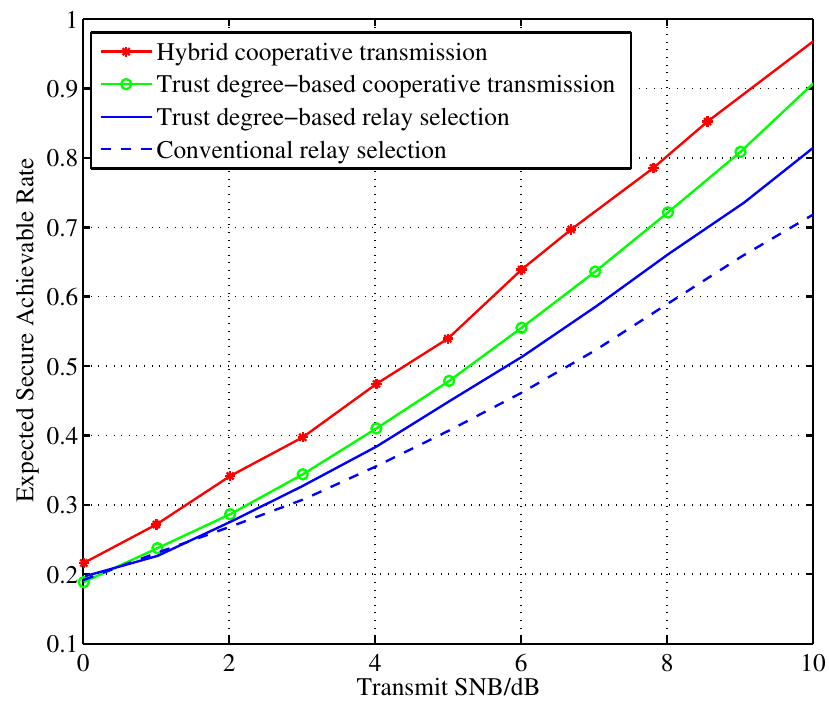
Figure 7. Expected achievable rate versus transmit SNR ( α 1 = 0.6, α 2 =